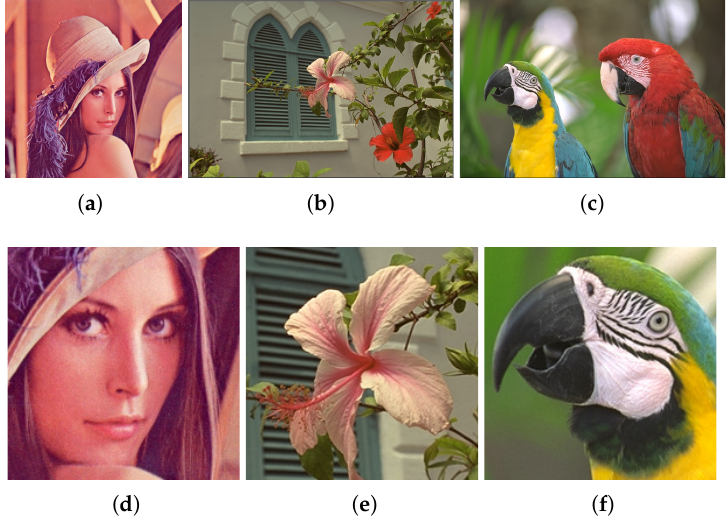
Figure 1. Images used in experiments. ( a ) Lena, ( b ) Flower, ( c ) Parrots, and ( d – f ) details taken for the